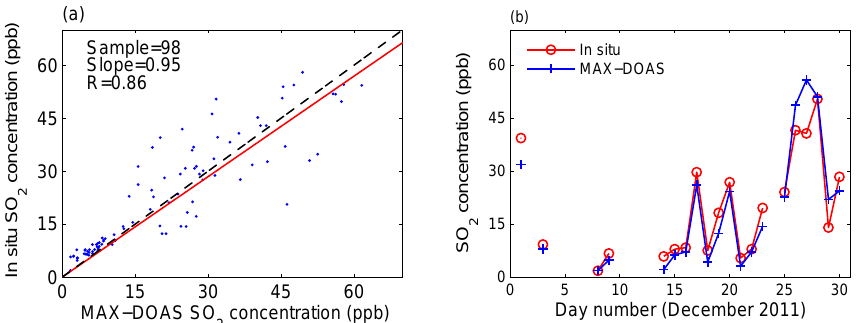
Figure 8. (a) Scatterplot of in situ SO 2 surface concentrations (0–200m layer) against MAX-DOAS data for December 2011 (hourly averaged concentrations). The red line denotes the linear least-squares fit to the data. (b) Temporal evolution of daily averaged MAX-DOAS and in situ SO 2 concentrations during December 2011. Gaps in the data series are due to missing MAX-DOAS measurements.